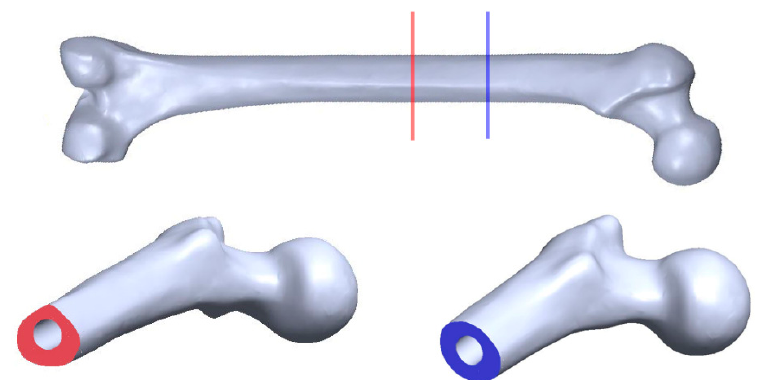
Figure 1. 3D scanned bone showing triangular and circular cross-sectional areas at different anatomic locations.